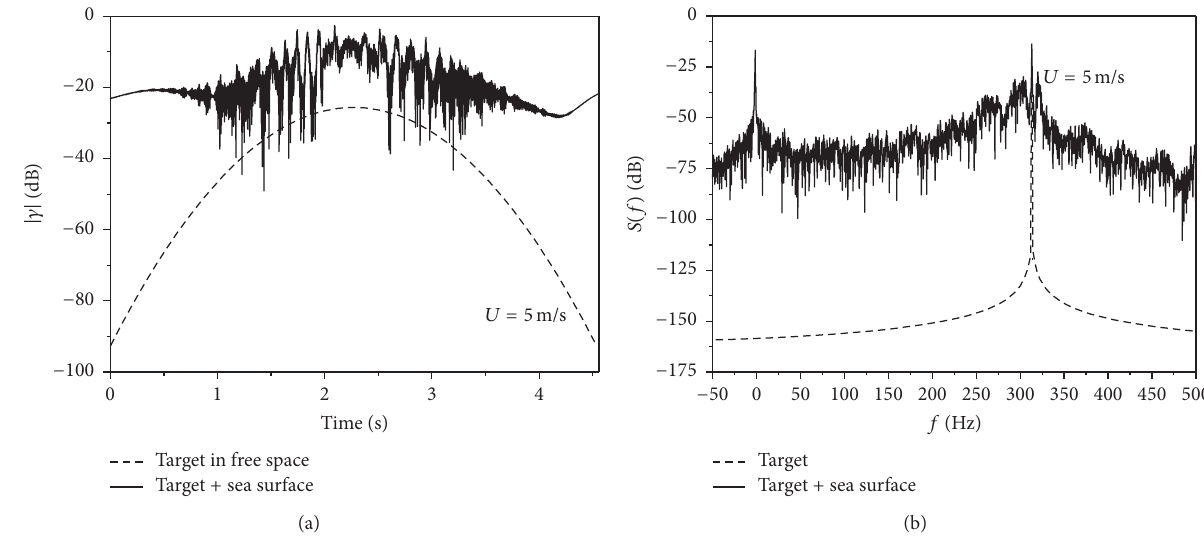
Figure 4: Target above sea surface and in free space. (a) Scattering amplitude. (b) Doppler spectra.